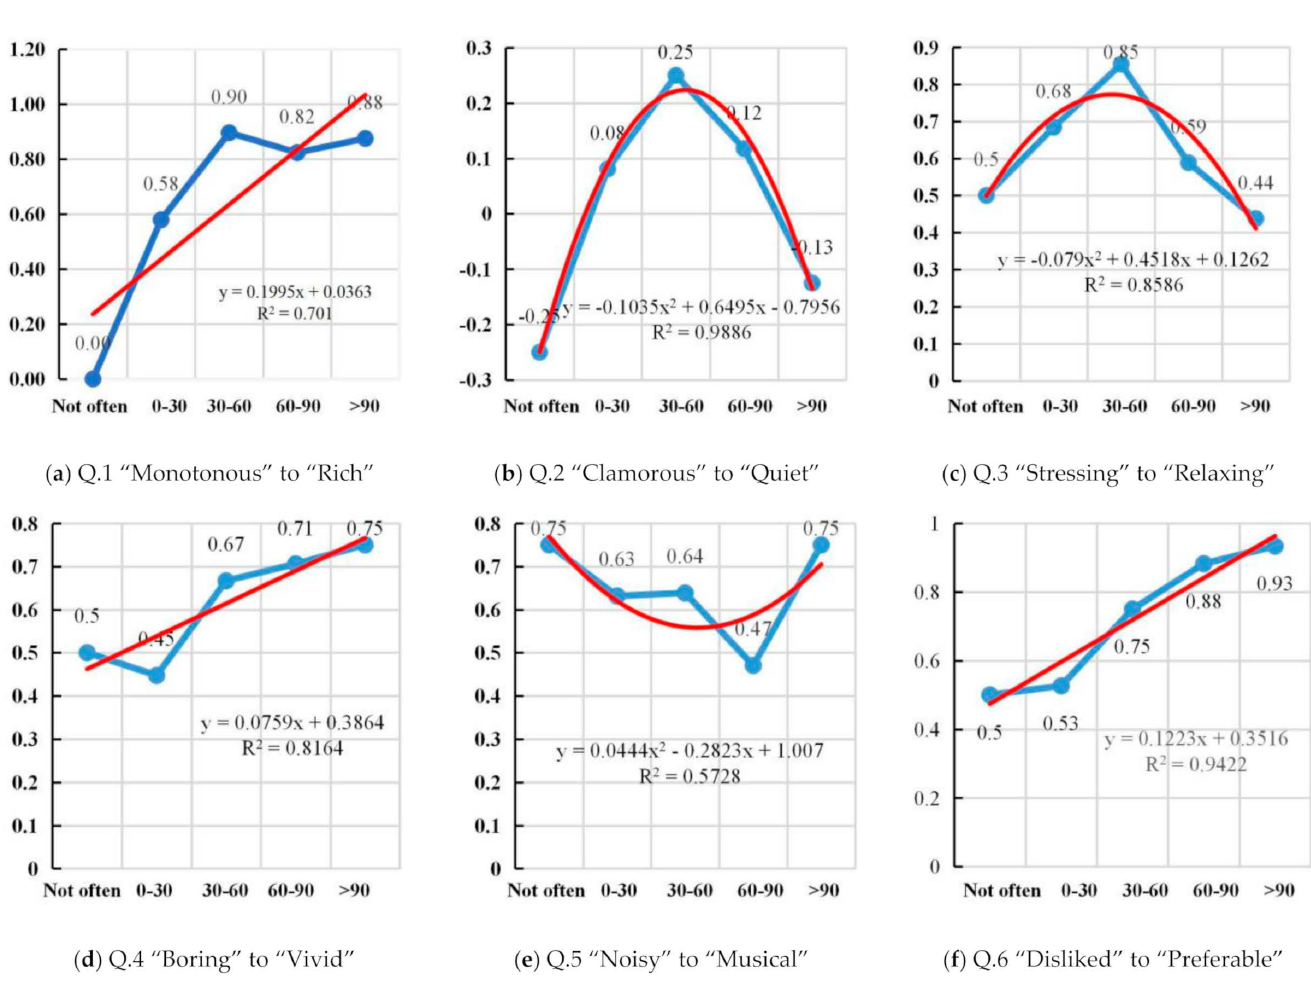
Figure 3. Curve-fit mapping results of average scores ( y -axis in the suitable scale for each question) distribution with the “ Length of Listening (LOL) ” ( x